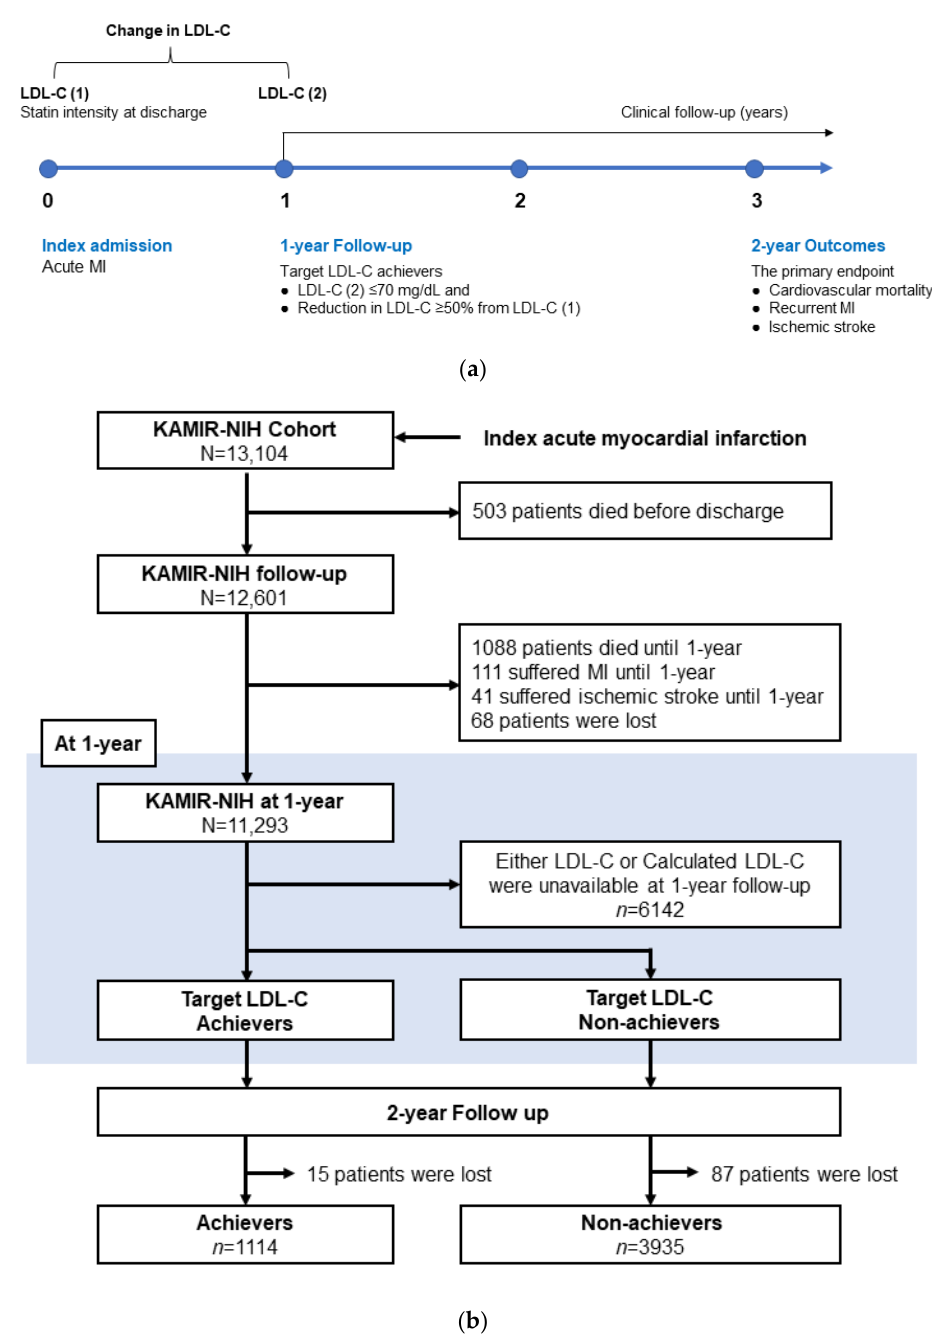
Figure 1. Study population. Flow chart of the study ( a ) and patient demographics according to flow chart ( b ). KAMIR-NIH, Korean Acute Myocardial Infarction Registry-National Institutes of Health; LDL-C, low-density lipoprotein cholesterol; MI, myocardial infarction.